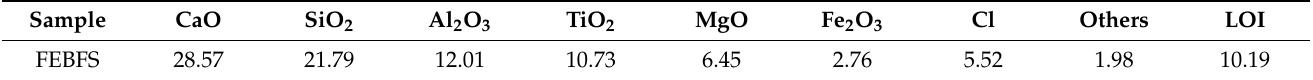
Table 1. Chemical composition of FEBFS samples (%).